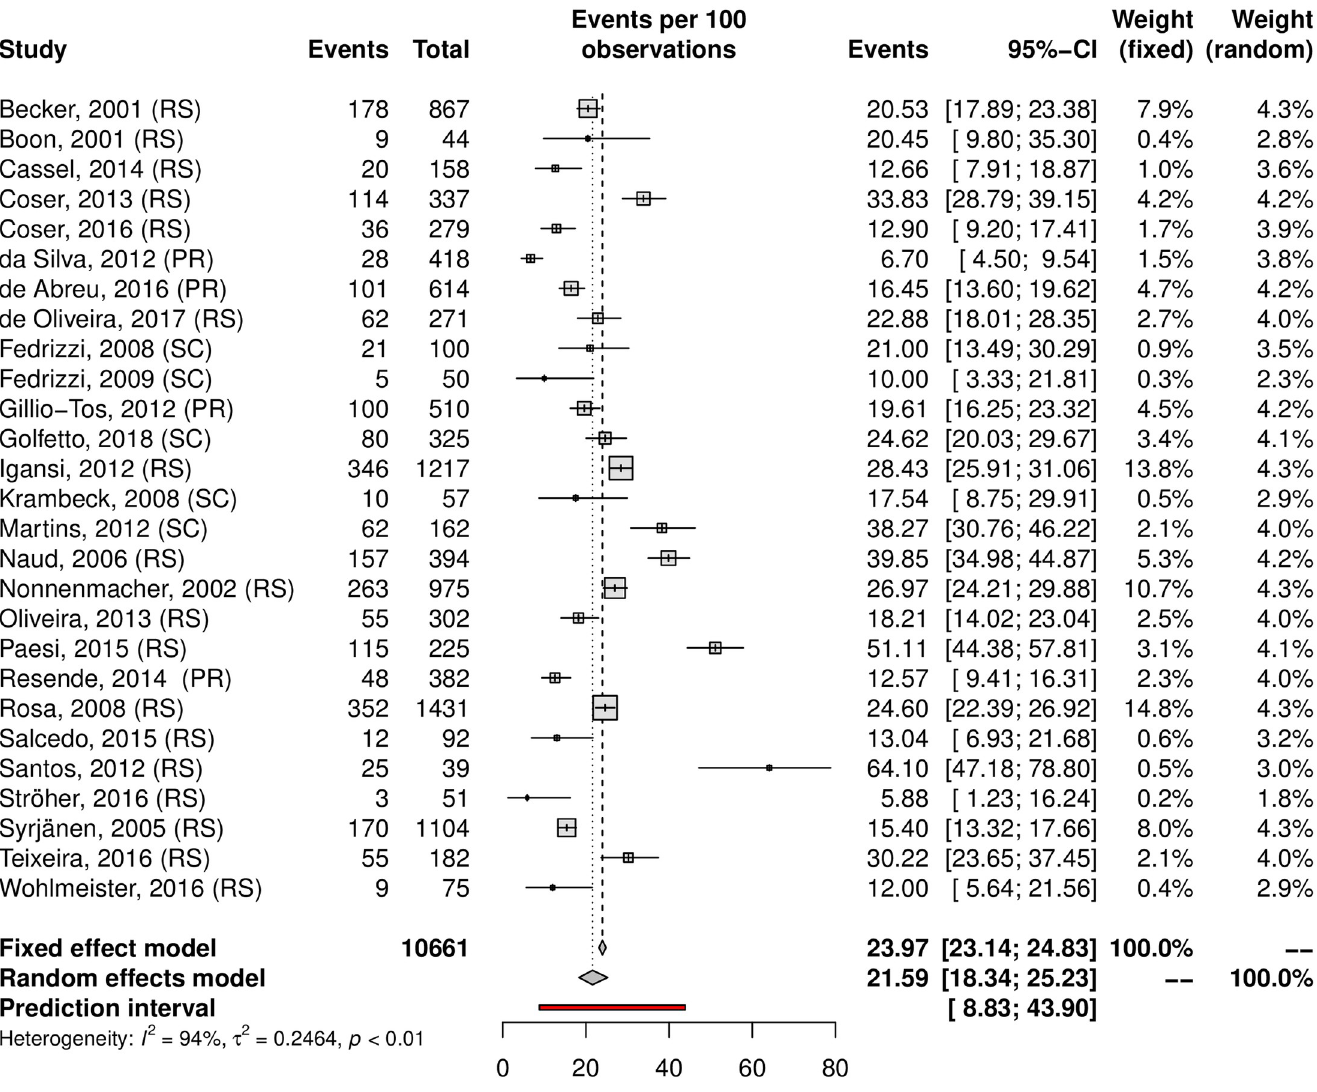
Fig 7. Prevalence of cervical HPV in the South region of Brazil. Forest plot of a metanalysis of studies reporting prevalence of cervical infection by HPV in the South region of Brazil.